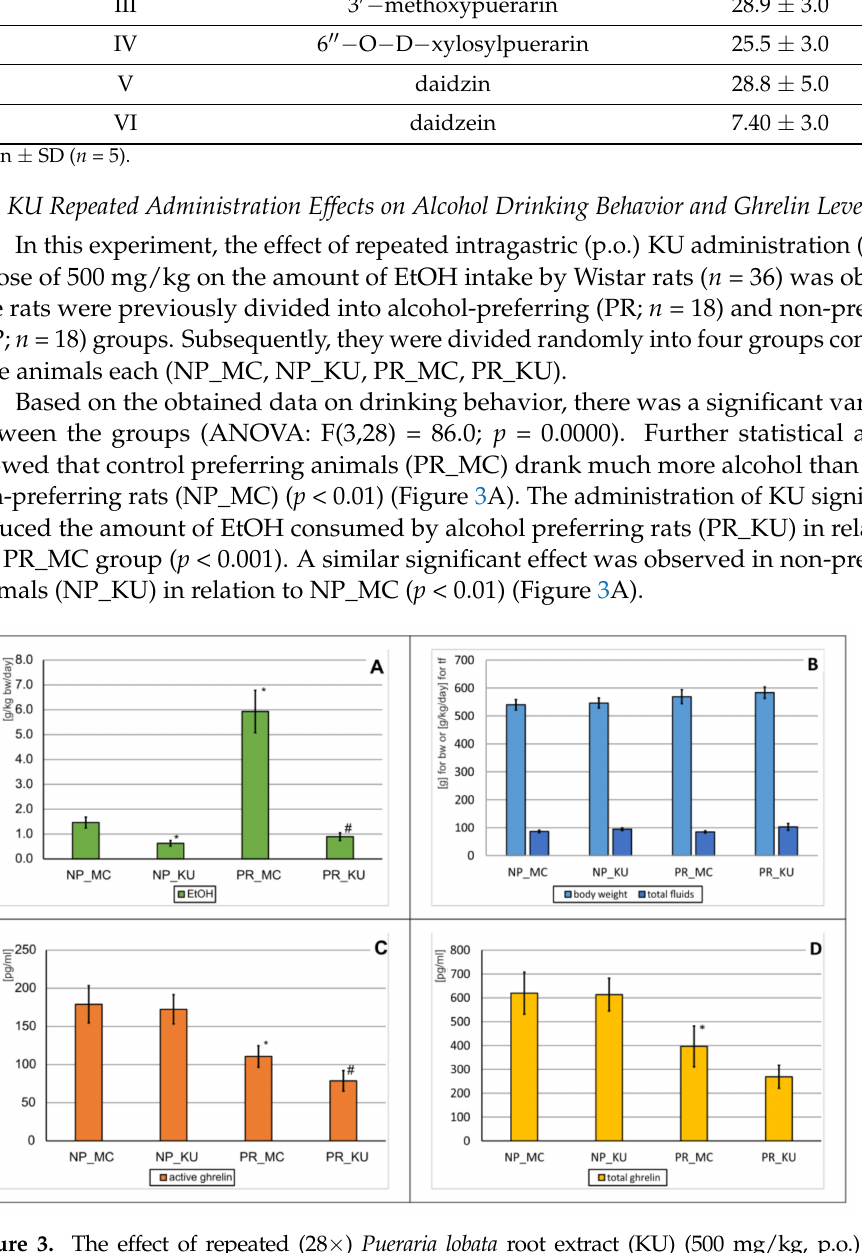
Figure 3. The effect of repeated (28 × ) Pueraria lobata root extract (KU) (500 mg/kg, p.o.) admin- istration on alcohol drinking behavior, total fluid intake, body weight and ghrelin levels in prefer- ring (PR) and non-preferring (NP) rats. Legend: n = 8–9; mean ± SEM; PR_MC—control PR rats; NP_MC—control NP rats; MC—vehicle (0.5% methylcellulose); ( A ) amount of drunk ethanol